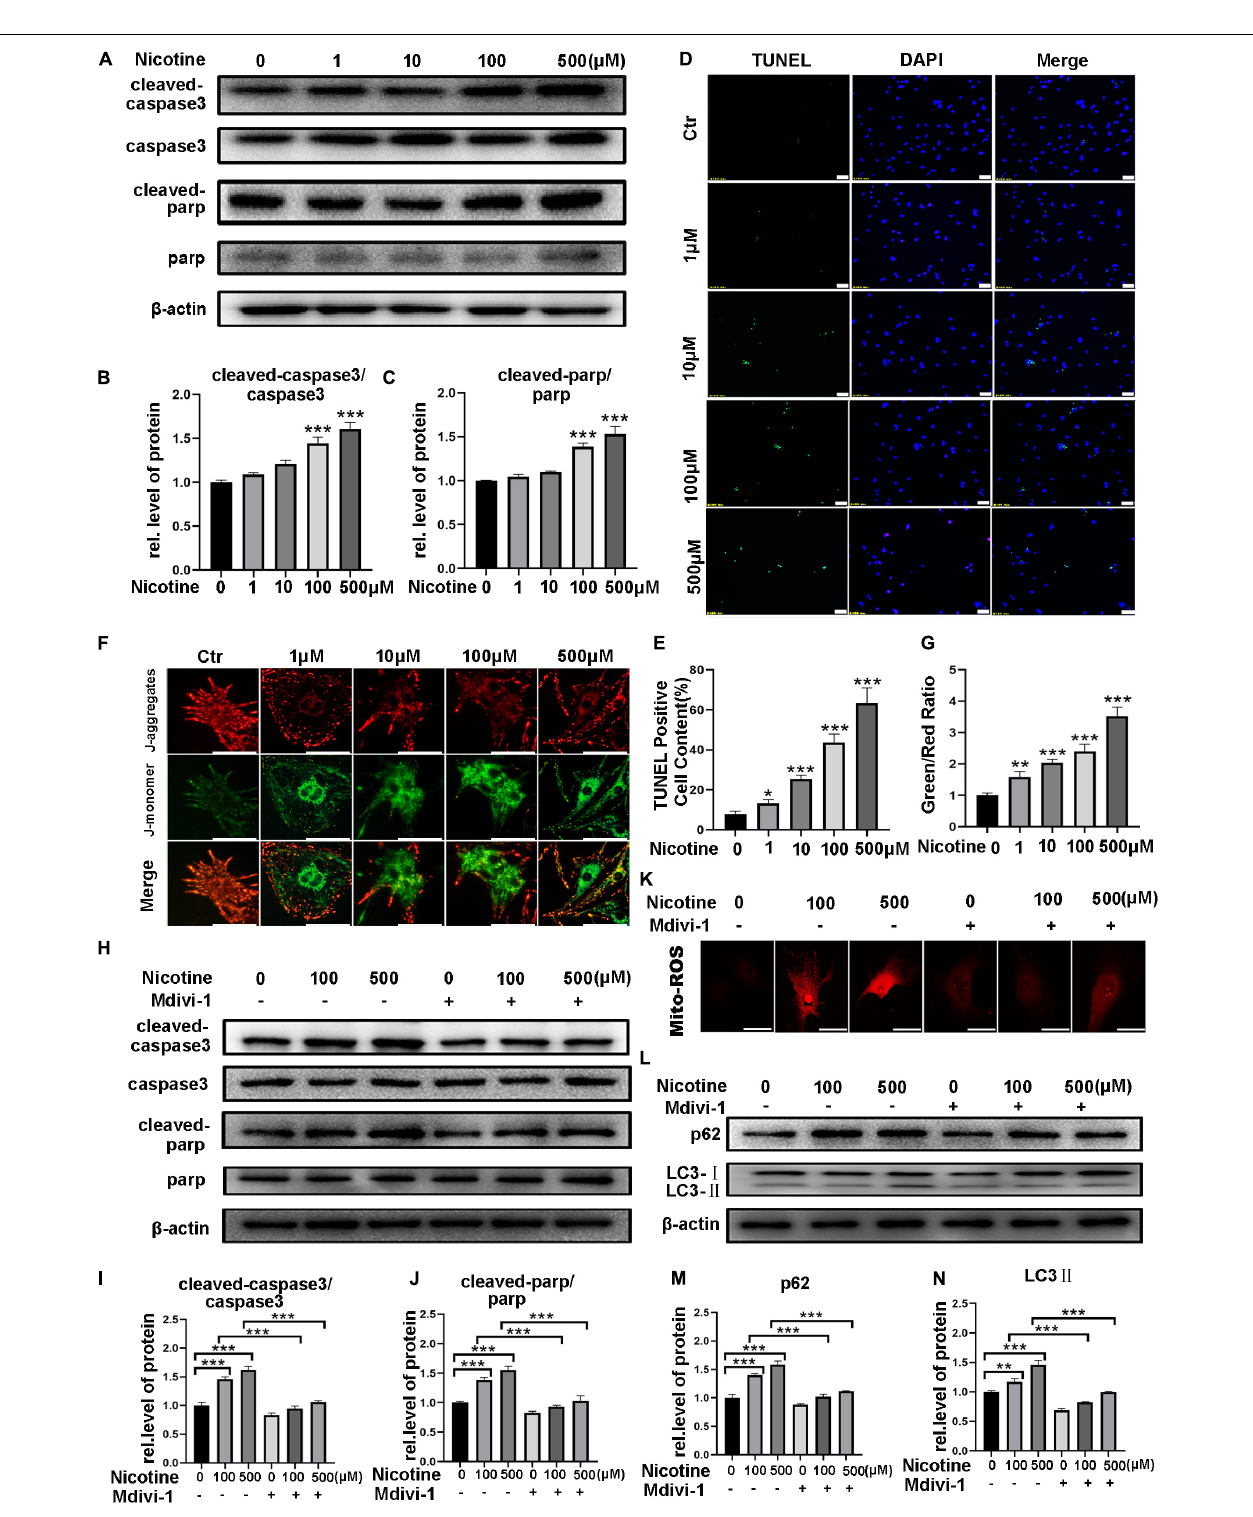
FIGURE 6 | Nicotine caused cardiomyocyte apoptosis, which attenuated by mdivi-1. (A) Western blotting was performed to detect apoptosis markers cleaved-caspase3, caspase3, cleaved-PARP, PARP protein levels of NRVMs after treating with nicotine. (B,C) Image J was used to quantification (*** p < 0.001, n = 3) . (D–E) TUNEL assay of apoptotic cardiomyocytes induced by nicotine (Scale bar = 50 µ m). (F,G) JC-1 staining was used to demonstrate the variety of mitochondrial membrane potential (Scale bar = 20 µ m). (H–J) Western blotting analysis of apoptosis related protein treated by mdivi-1. (K) Mdivi-1 decreased the generation of mito-ROS (Scalebar = 20 µ m). (L) Western blot was performed to determine the autophagy marker LC3-II and its specific substrate p62 expression. (M,N) Image J was used to quantification (*** p < 0.001; ** p < 0.01; * p < 0.05, n = 3).